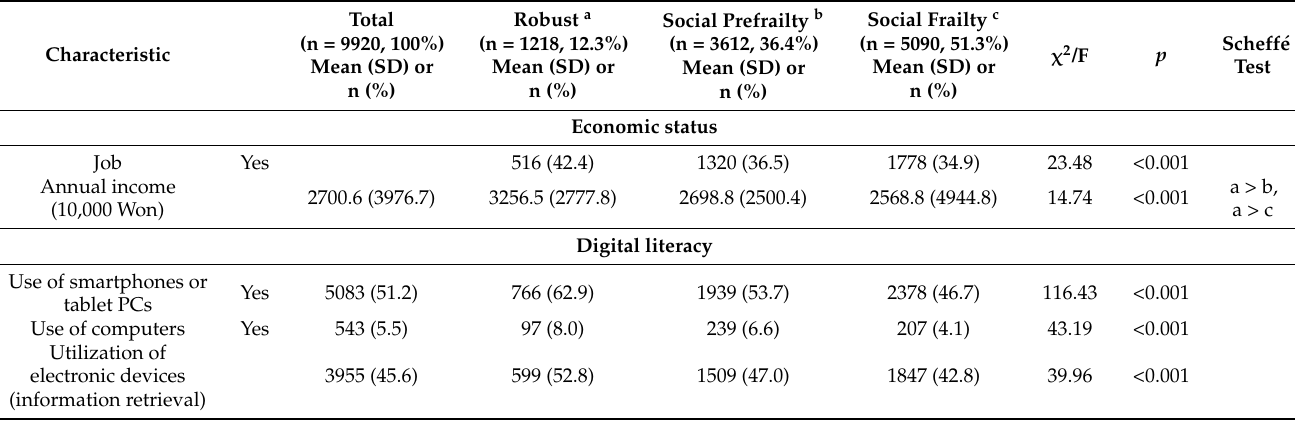
Table 2. Differences in economic status and digital literacy of participants in the robust, social prefrailty, and social frailty groups (N =